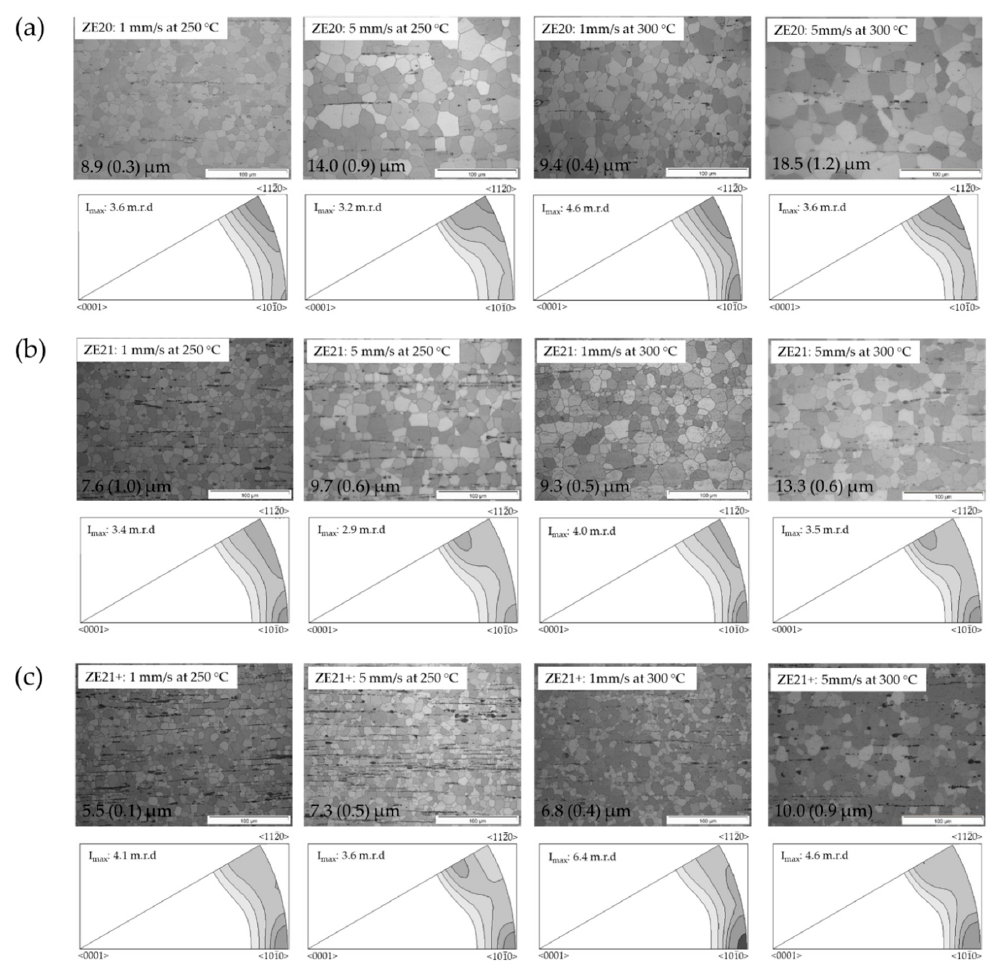
Figure 3. Micrographs from longitudinal sections and inverse pole figures in the extrusion direction of extruded Mg-Zn-Ce alloy (ZE-series alloys) at varied temperatures and extrusion speeds; numbers indicate average grain sizes: ( a ) ZE20; ( b ) ZE21; ( c ) ZE21+.